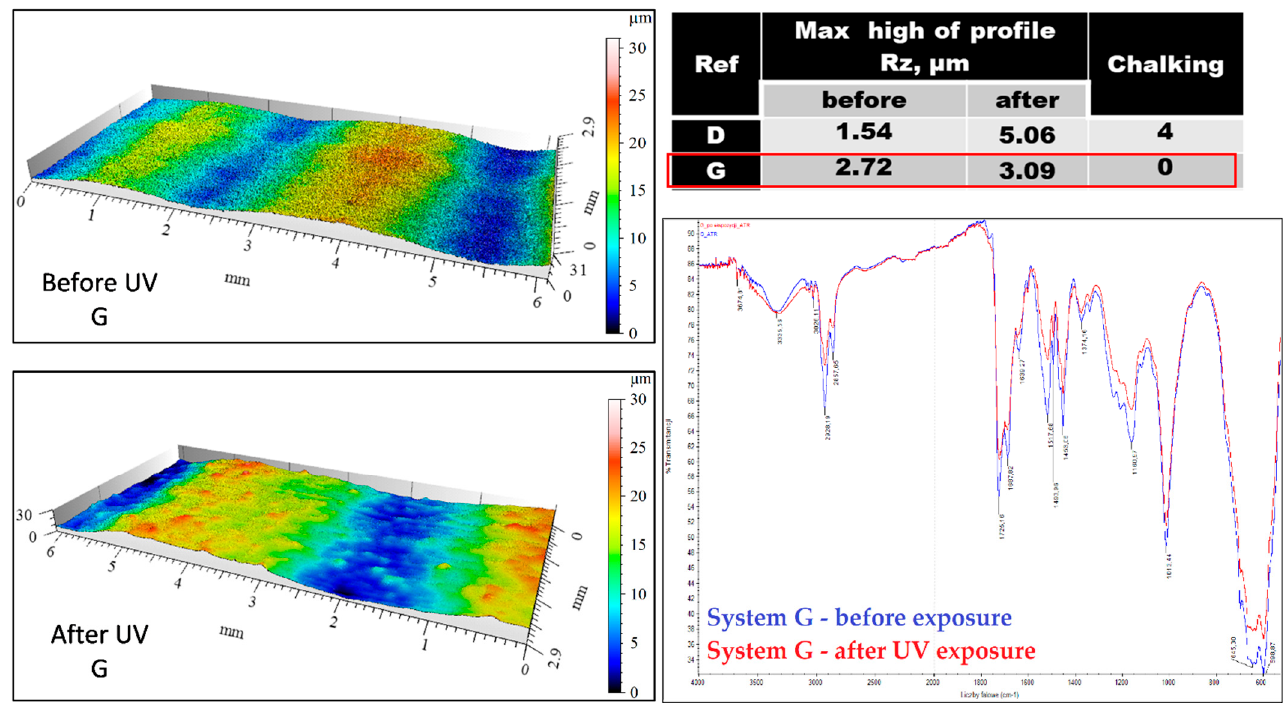
Figure 4. Surface profile and structure of the coating G before and after exposure to UV: smaller change in roughness → identical spectrum with spectrum before exposure.